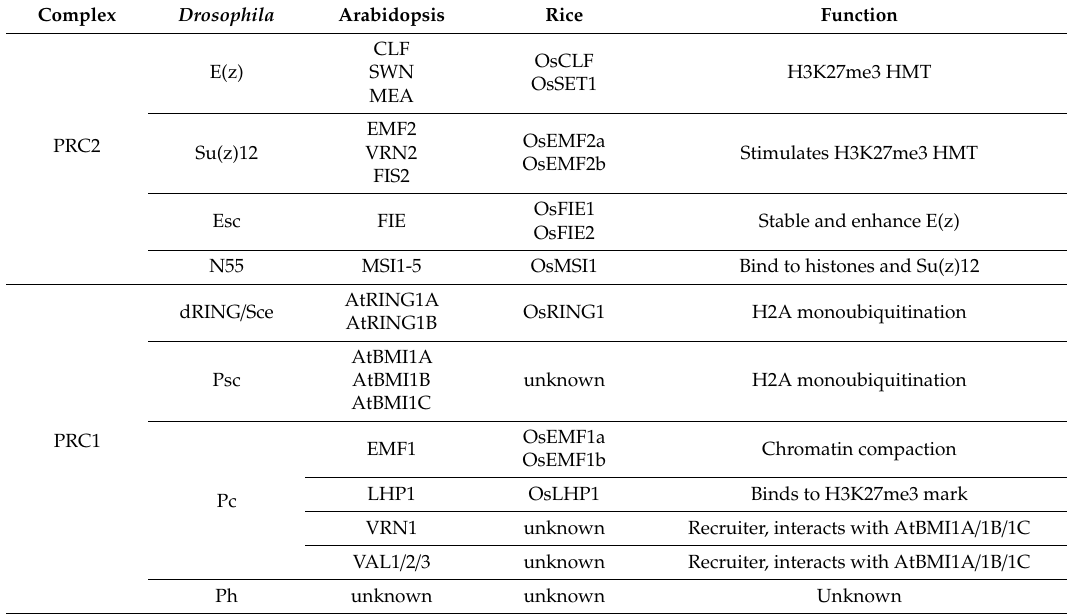
Table 1. Components of polycomb repressive complex 1 (PRC1) and polycomb repressive complex 2 (PRC2) complexes discovered in Drosophila , Arabidopsis, and